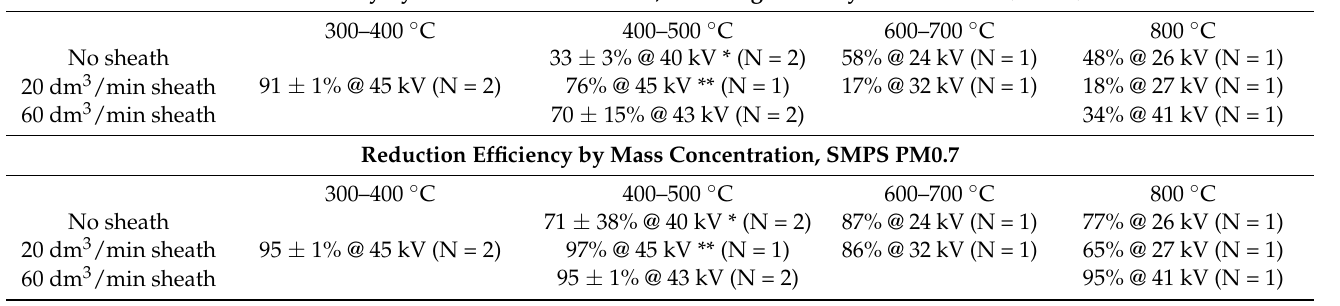
Table 3. Shielded corona charger (SCC)-induced particulate matter (PM) and particle number reduction efficiencies measured downstream of the condensing heat exchanger (CHX) in different SCC operating conditions. N is the number of repeated individual experiments. The result of each individual experiment is averaged over a measurement time varying between 10 and 40 min under stable